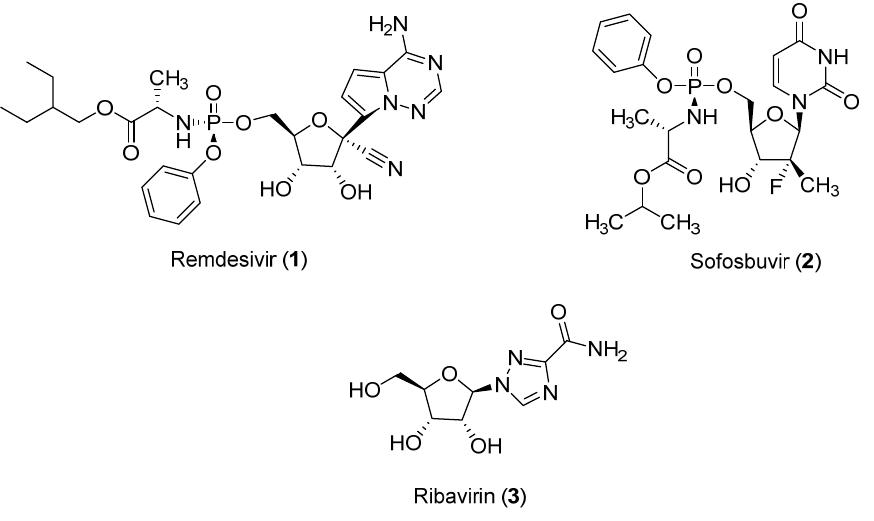
Figure 1. Remdesivir ( 1 ), Sofosbuvir ( 2 ) and Ribavirin ( 3 ). Nucleoside analogue inhibitors are chemically synthesized derivatives of a nucleobase conjugated with a sugar moiety in which either the heterocyclic ring or the sugar moiety has been modified (Figure 2). Nucleoside analogues could be used as anticancer agents [24–26], as antibacterial agents [27,28] and as antiviral agents [29,30].